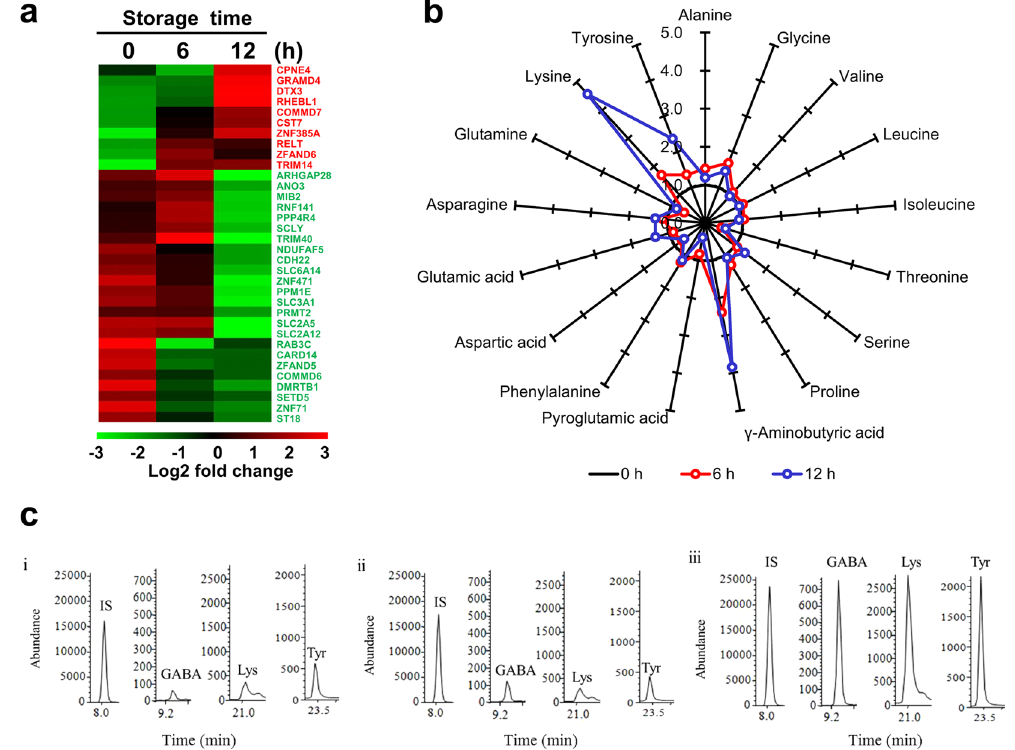
Figure 3. Changes in transcriptome and amino acid profiles in hBM-MSCs stored in PBS for 6 and 12 h. ( a ) Heat map of genes with altered expression; 34 genes related to amino acid metabolism were differentially expressed at 6 and 12 h according to a microarray analysis. Red and green areas indicate up- and downregulated genes, respectively. ( b ) Star plot showing altered levels of 17 amino acids after 6 and 12 h of incubation in hBM-MSCs. Data are based on percentage mean composition levels of 17 amino acids after normalization to the corresponding values in the control group. Three independent experiments were performed. Selected-ion monitoring (SIM) chromatograms of GABA, lysine, and tyrosine in (i) 0 h control (ii) 6 h group (iii) 12 h group. IS, Internal standard